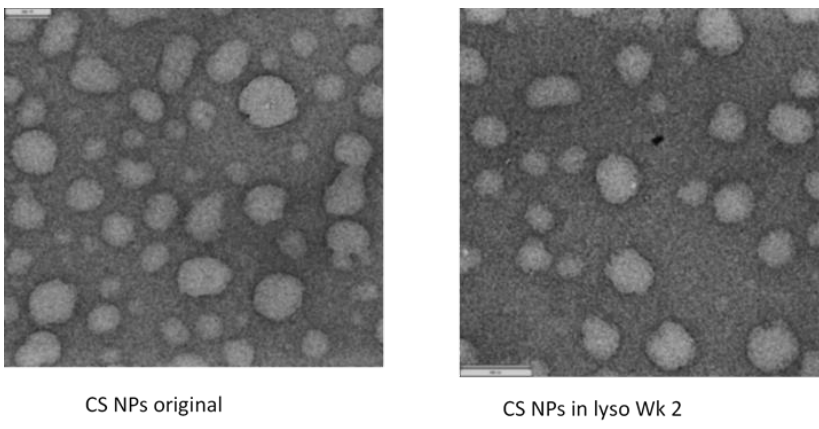
Figure 6. Particle size and size distributions of CS NPs.